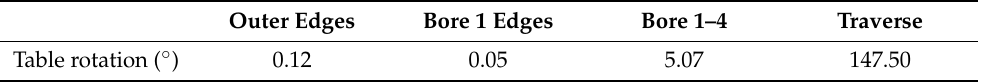
Table 6. Maximum rotational difference on different toolpath